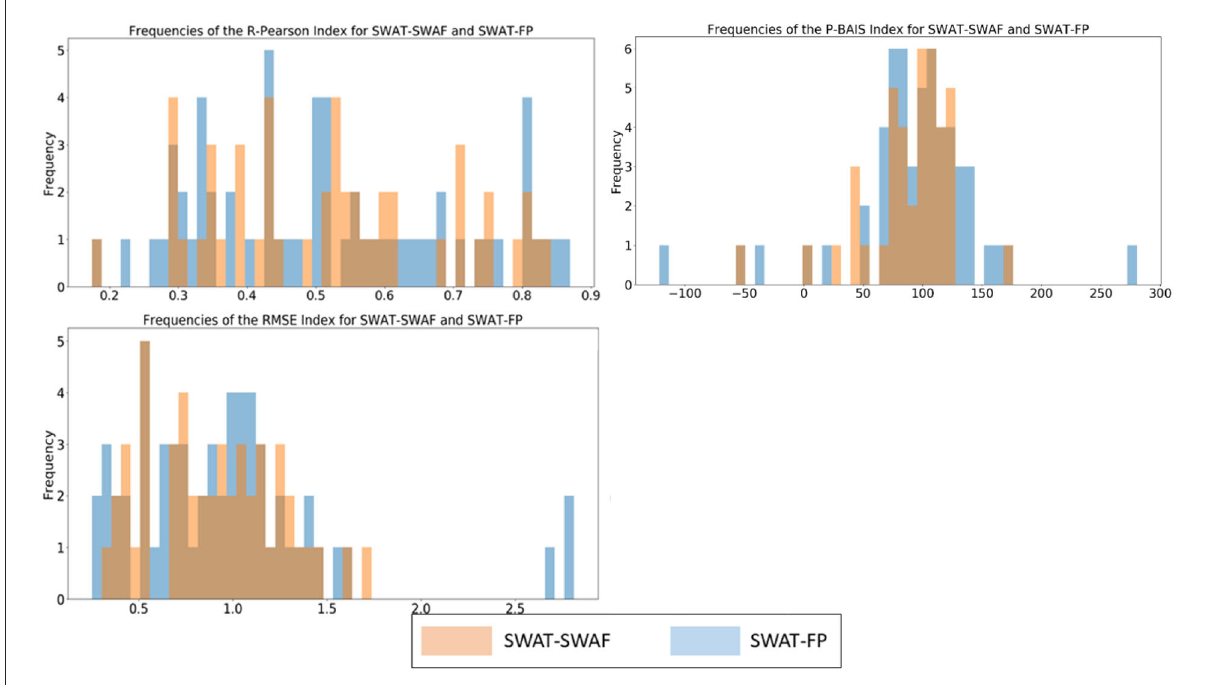
FIGURE8 Histograms of the R-Pearson, p-bias, and RMSE indexes for both frameworks.